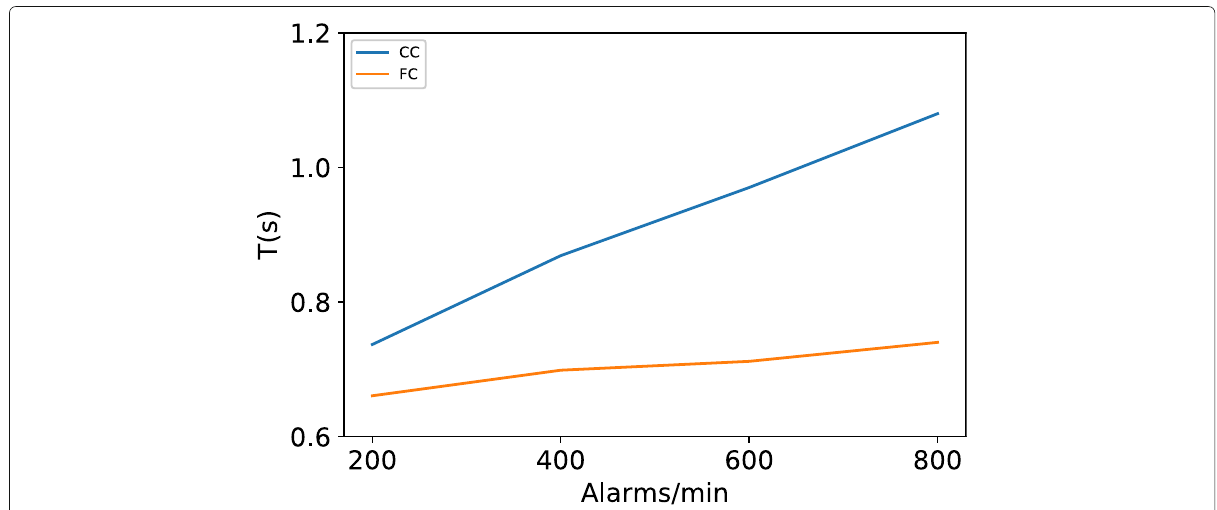
Fig. 9 Average Latency for the Different Loads Established, Comparing Fog Computing (FC) and Cloud Computing (CC)